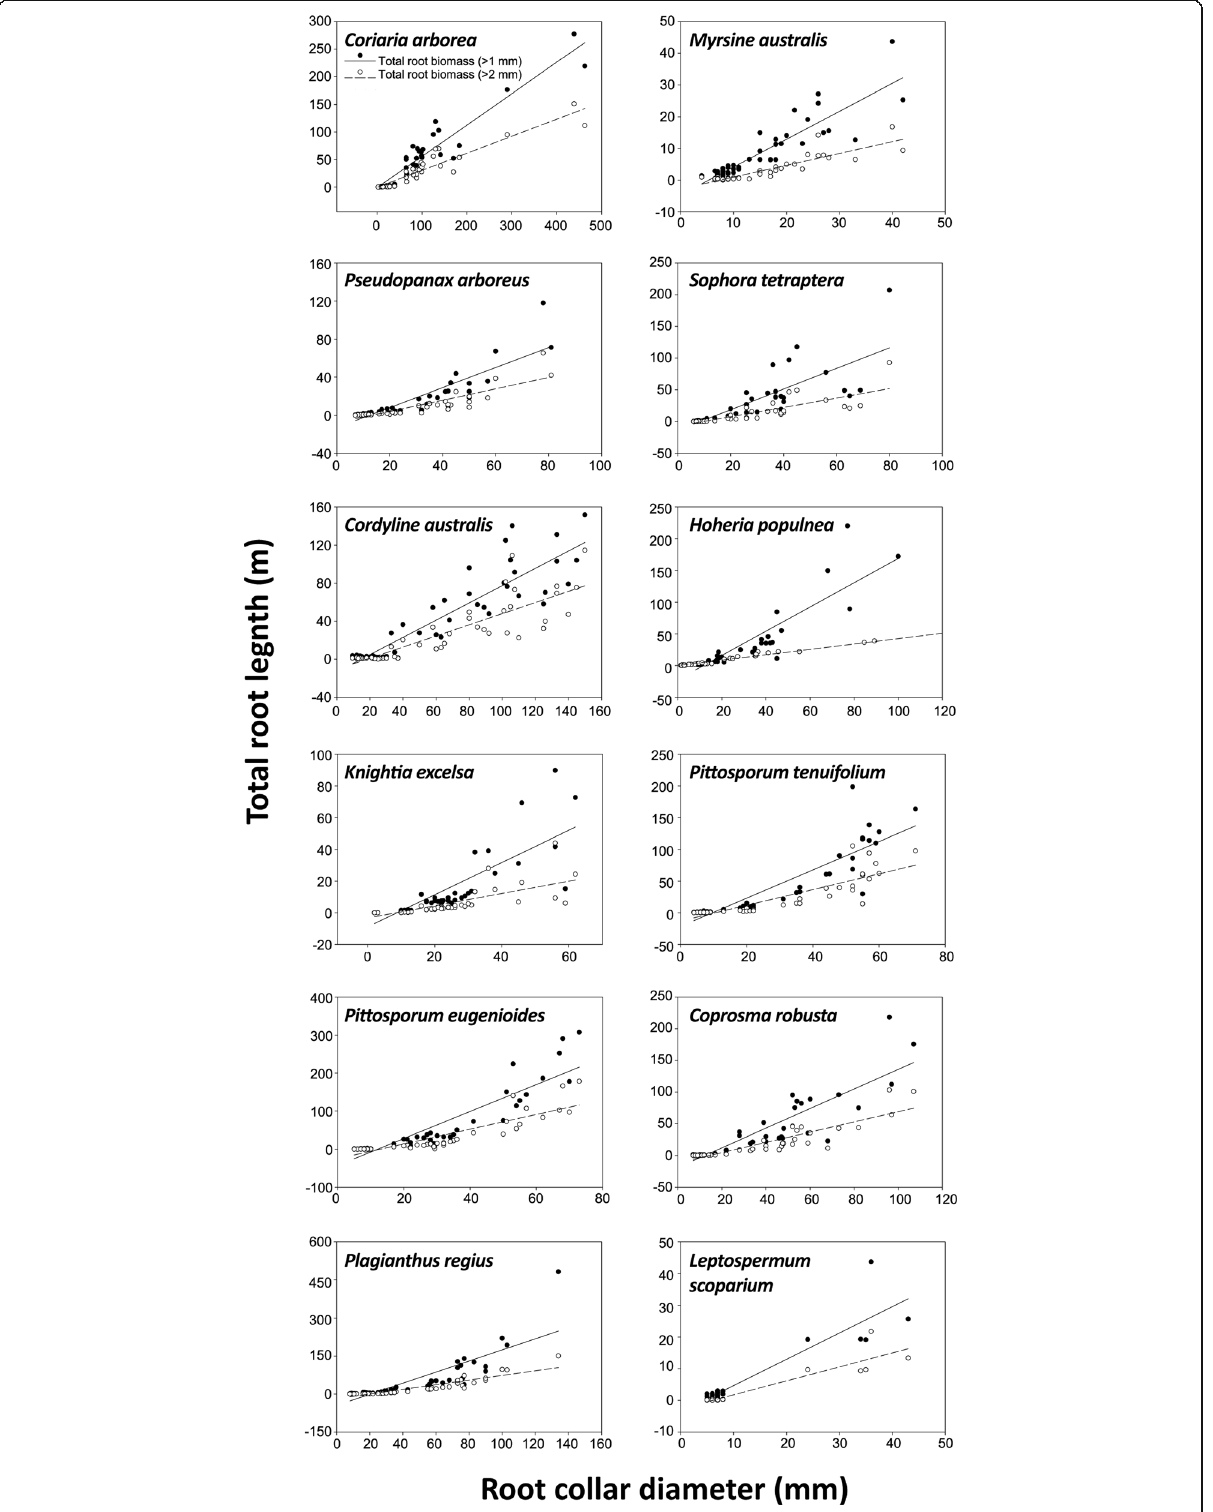
Fig. 5 Linear analysis of RCD and total root length for roots > 1 mm (black circle) and > 2 mm (white circle) diameter. Regression equations are presented in Table